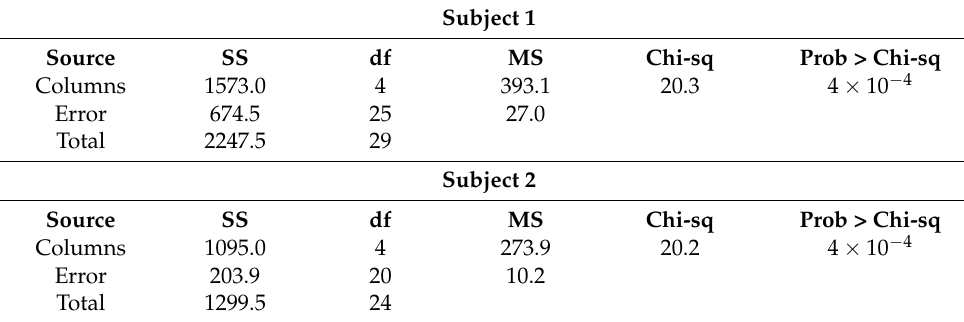
Table 2. Kruskal-Wallis ANOVA table for AUC at the diaphragm.